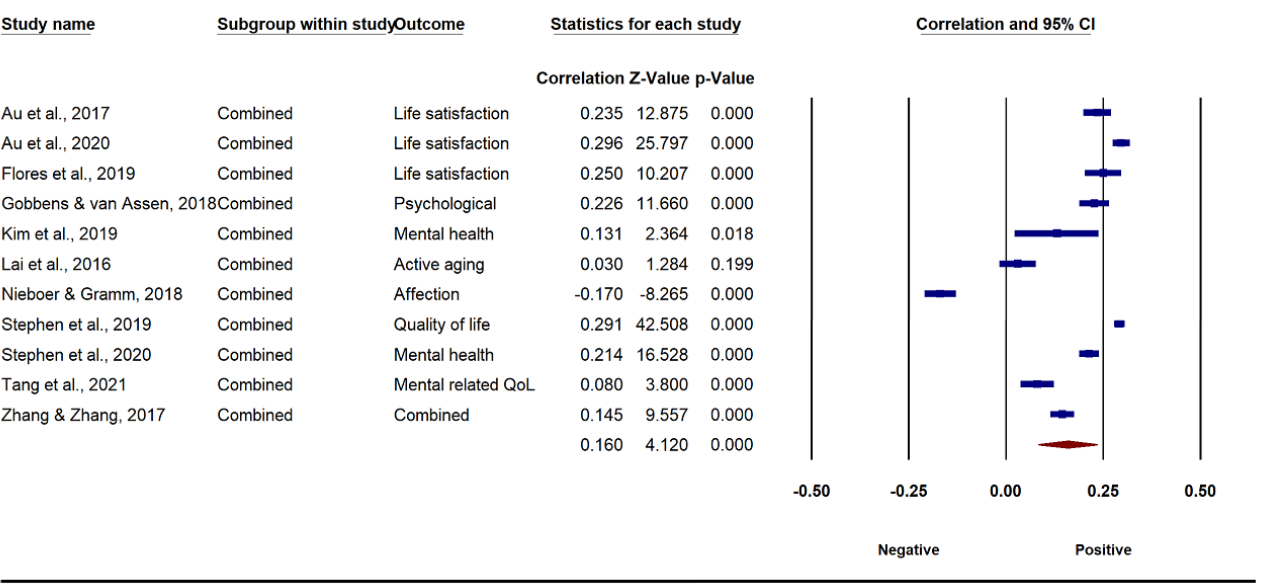
Figure 3. Forest plot of the association between AFEs and mental well-being.